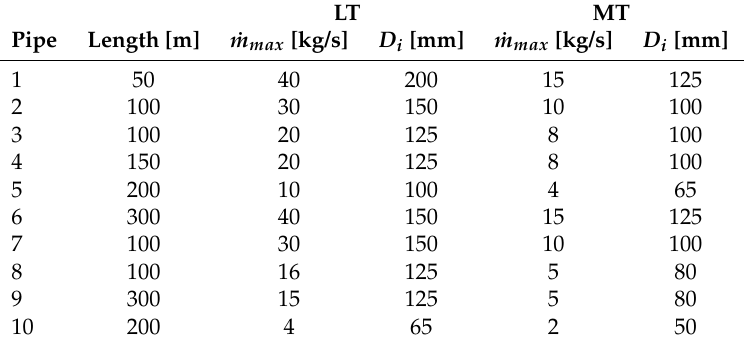
Figure 2. A schematic of the model in Dymola, consisting of a heat centre and two network branches supplying heat to 10 buildings: 5 apartment blocks, a nursing home, a kindergarten, an office building, a retail store and a sports building. Table 2. The pipe lengths, selected dimensioning mass flow rates and resulting inner pipe diameters for the low temperature (LT) and medium temperature (MT) case. The pipe numbering is as shown in Figure 2.